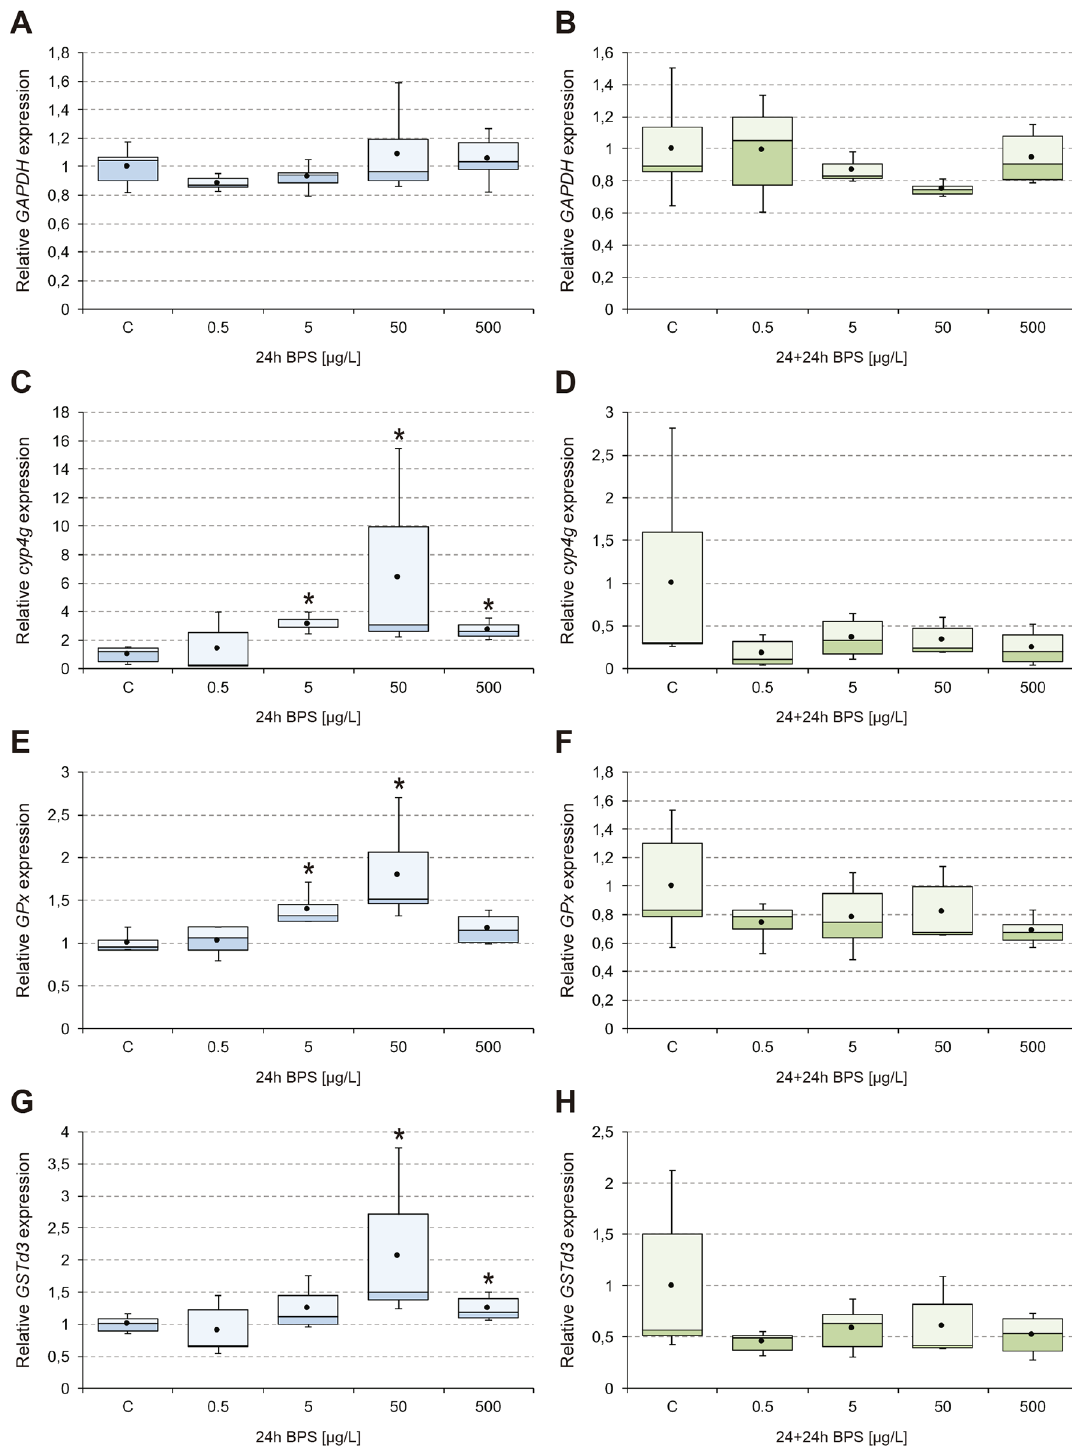
Fig 3. Transcriptional activity of GAPDH , cyp4g , GPx , and GSTd3 . Box-and-whisker plots represent the expression patterns of GAPDH (A-B), cyp4g (C-D), GPx (E-F), and GSTd3 (G-H) measured by real-time RT-PCR. C . riparius fourth instar larvae were exposed to 0.5–500 μg/L BPS for 24 h (24h; left column; blue series), and maintained for an additional 24 h in fresh culture medium after BPS withdrawal (24+24h; right column; green series). Four independent experiments were performed and RNA was extracted from 5 larvae for each experimental condition (n = 20). Results were normalized to control values. Box and whiskers represent the 25–75 percentile